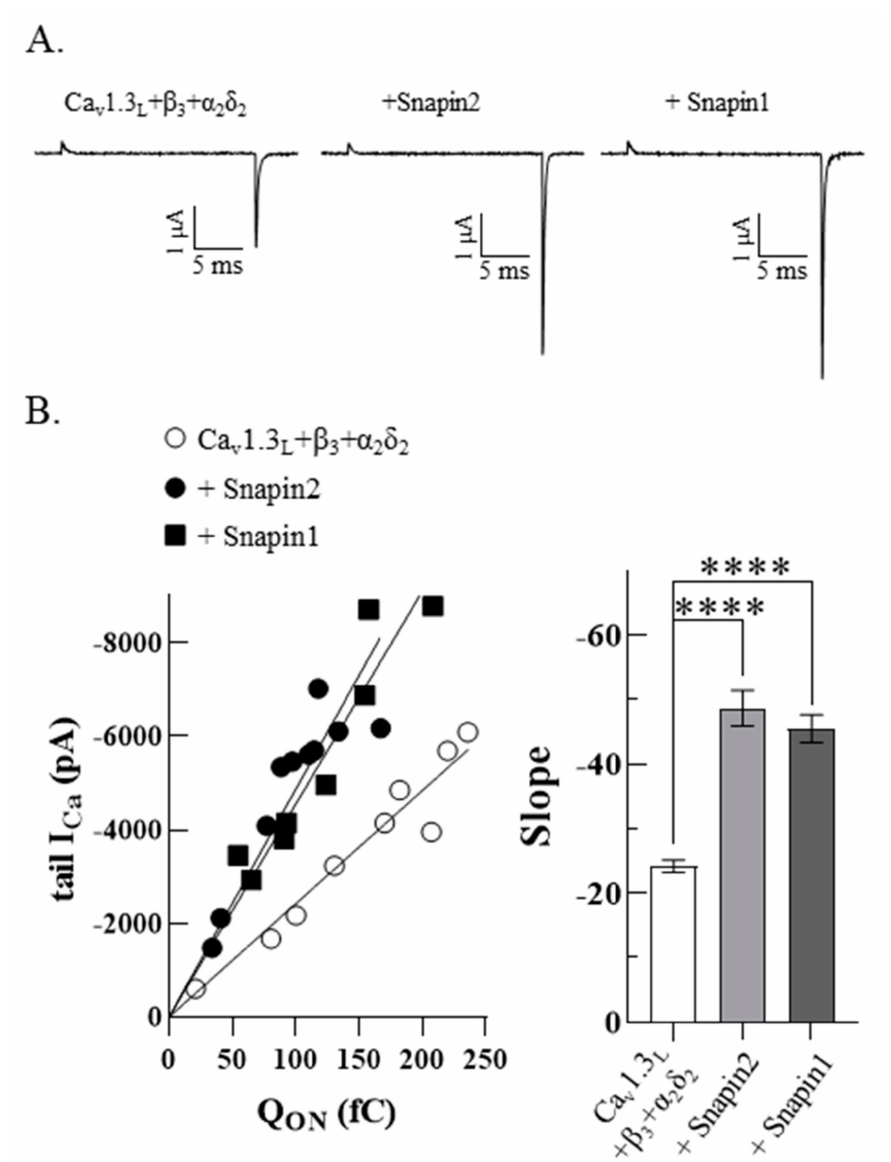
Figure 8. Increment of opening probability of Ca v 1.3 L channels by Snapin. ( A ) Representative gating current and tail current of Ca v 1.3 L / β 3 / α 2 δ 2 co-expressed without or with Snapin 1 or 2. ON-gating currents were measured upon depolarizing to the virtual reversal potential from a holding potential of − 80 mV and tail currents were measured upon repolarizing to − 80 mV holding potential from